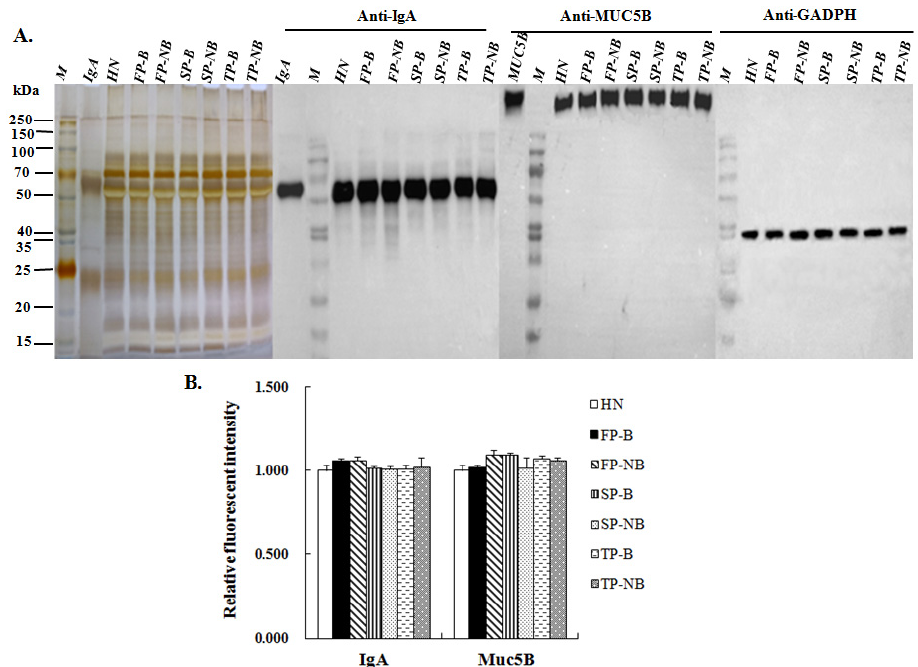
Figure 4. Analysis ofthe MUC5B and IgA expression level in different saliva groups. ( A ) The binding images of salivaryproteins corresponding to human anti-MUC5B or anti-IgA antibody, glyceraldehyde-3-phosphate dehydrogenase (GAPDH) was used as the loading control. ( B ) RFIs of the binding bands of salivary proteins corresponding to human anti-MUC5B or anti-IgA antibody. Data shown are mean ± SD, statistical notations and group abbreviations are same as shown in Figure 1.